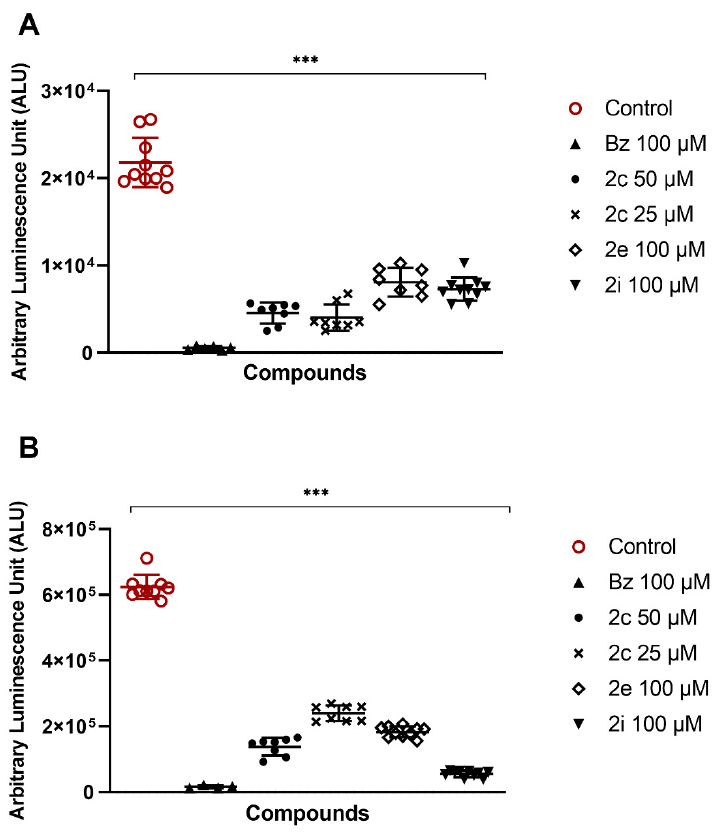
Figure 7. Analysis of 2c , 2e , and 2i treatment on parasite recrudescence in vitro. After 72 h treatment, the compounds were removed, and after culture washing, drug-free medium was added for an additional 72 h culture. The luminescent signal, corresponding to parasite viability, was performed on both supernatant ( A ) and T. cruzi ‐ infected Vero cell monolayers ( B ). Statistical significance, in relation to the untreated group, was determined using the One ‐ Way ANOVA test, with p < 0.001 (***). Bz treatment (100 μ M) sustained the parasite clearance in both supernatant and cell monolayers. Compounds 2c (50 μ M) and 2i (100 μ M) were the most effective in control ‐ ling the intracellular amastigotes proliferation, inhibiting 78% and 89% of cell monolayer infection, respectively, compared to 2e (69% inhibition) (Figure 7). Among the pyrazole ‐ thiazoline derivatives, 2c stands out for reducing by 85% the release of trypomastigotes in the culture supernatant (Figure 7). It is possible that prolonged treatment with the drug ‐